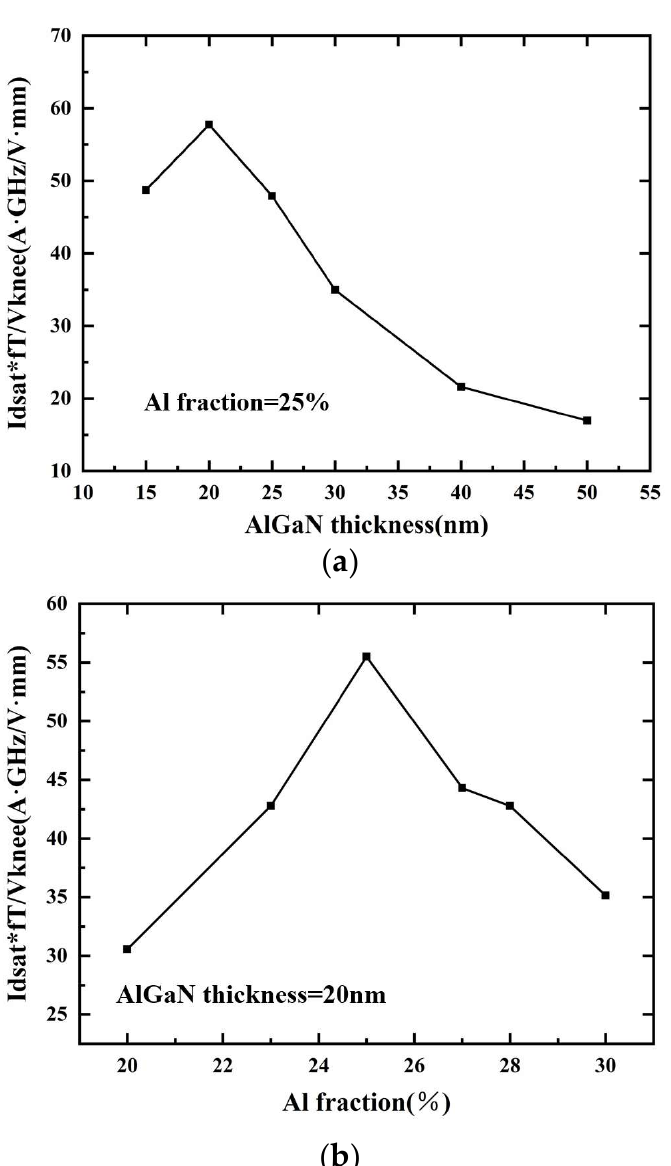
Figure 11. Calculation results of Optim values: ( a ) Optim values under different barrier layer thicknesses; ( b ) Optim values under different barrier layer Al fractions.